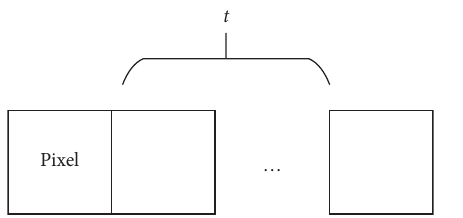
Figure 9: Transverse structure (Q) depicts the repetitive structure of the transverse regular texture.